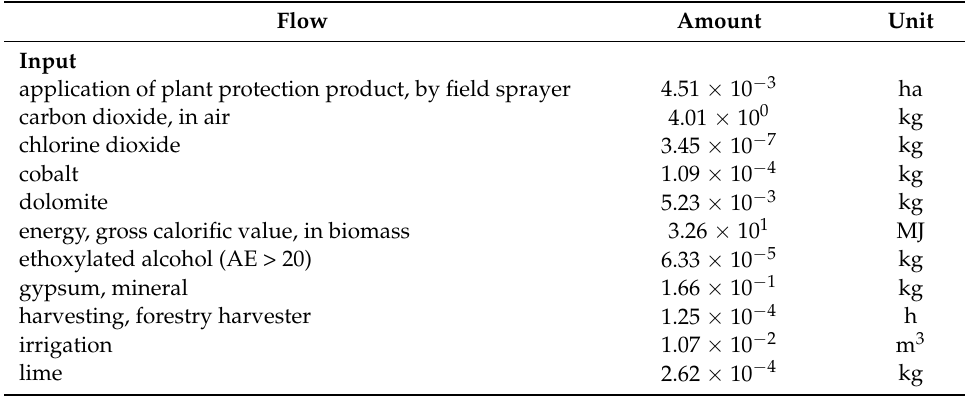
Table A2. Material inventory data for mango